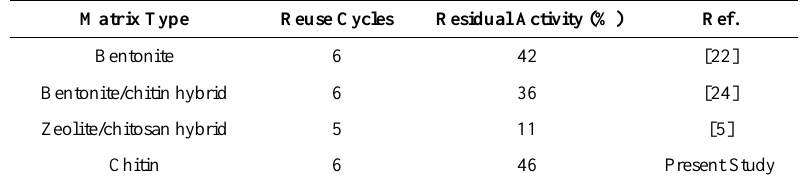
Table 5. Reusability study for immobilized A. fumigatus α-amylase in the latest